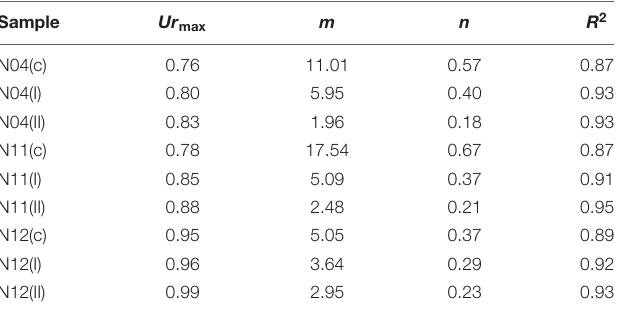
TABLE 4 | Ur max and decaying index of U r .